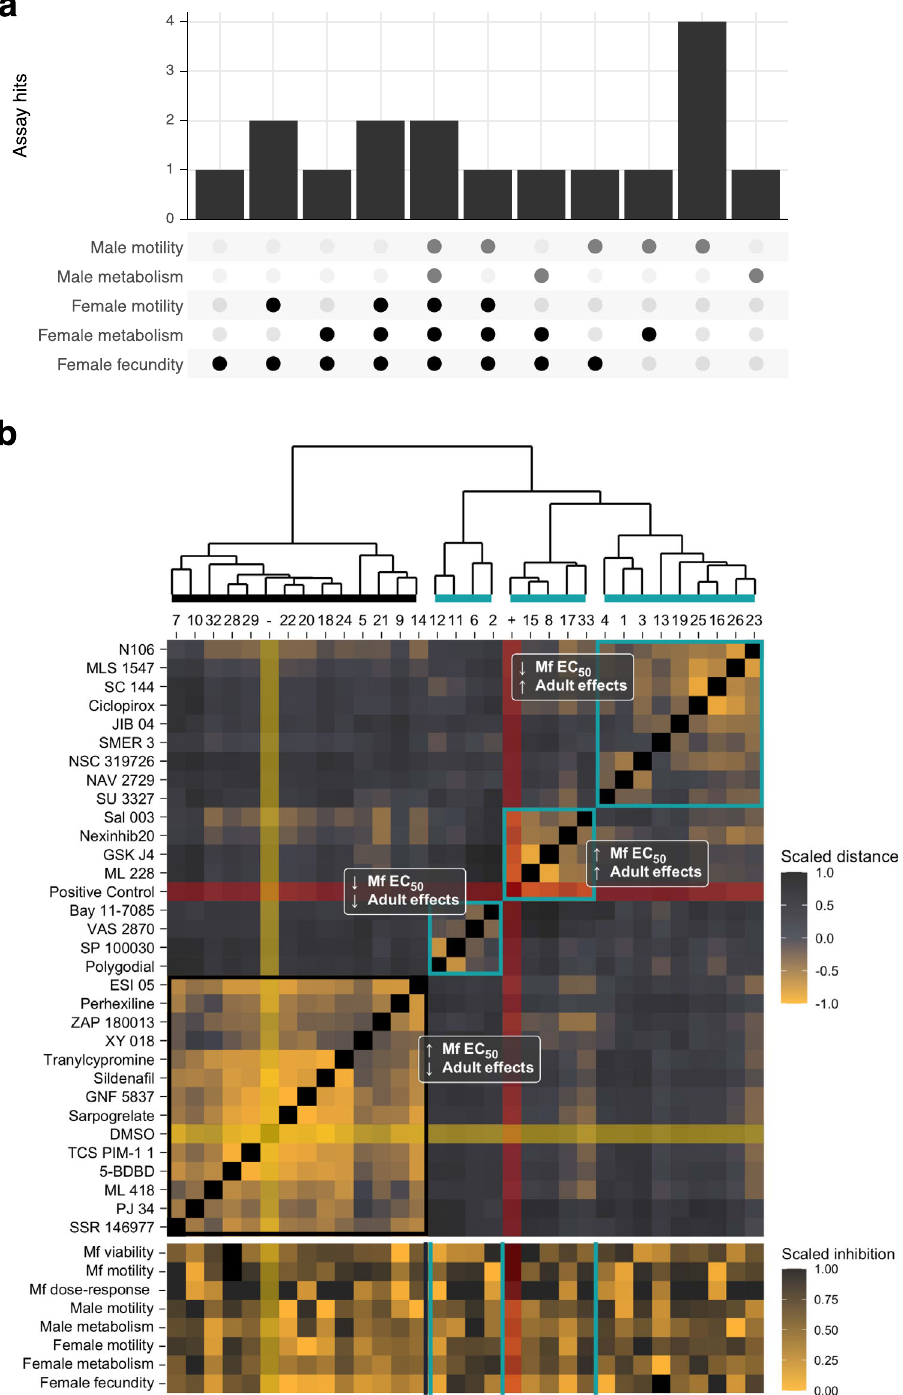
Fig. 7 Anti fi larial hits cluster into four phenotypic groups. a Tally of the number of hits from each assay combination. For instance, two compounds were hits in all fi ve assays, and four compounds were hits in the male motility assay alone. b Hits against micro fi laria (mf) in the primary screen but failed to reproduce in the follow-up dose – response and had no effects against adults (black rectangle) clustered with the negative control (yellow highlight). Four compounds were potent against mf but had no effect on adults, fi ve compounds were relatively less potent against mf but had strong effects on adults, and the remaining hits (nine compounds) were potent against mf and adults (blue boxes). For the top panel, fi ll color represents the scaled Euclidean distance between compounds using every available phenotypic value. Distances were scaled between − 1 and 1 and compounds were clustered using Ward ’ s method. For the bottom panel, fi ll color represents the scaled inhibition such that the compound that caused the greatest effect in a given phenotype is given a value of